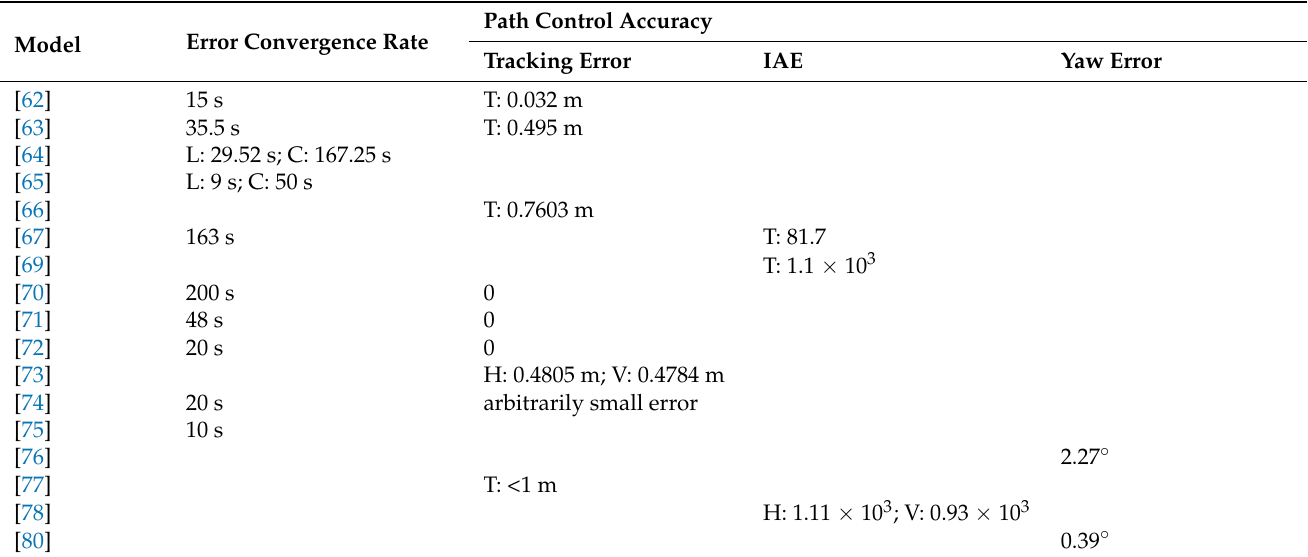
Table 7. Classification of intelligent collision avoidance methods during decision-making.